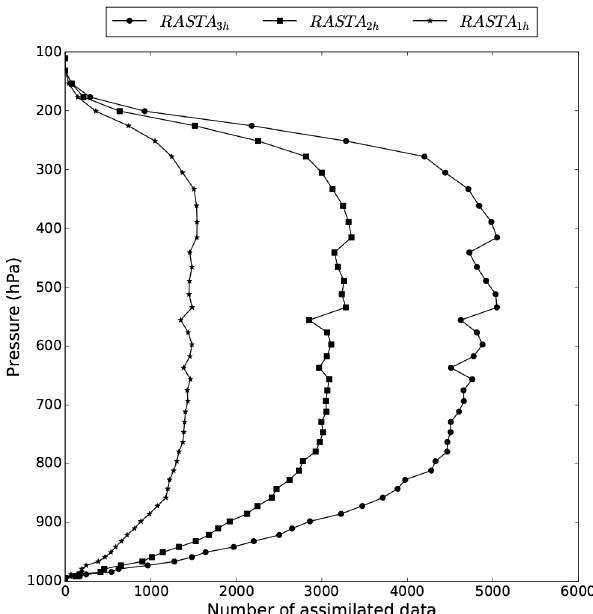
Figure 3. Number of RASTA horizontal wind data that are assim- ilated as a function of pressure for the RASTA SOP1 and RASTA 1h